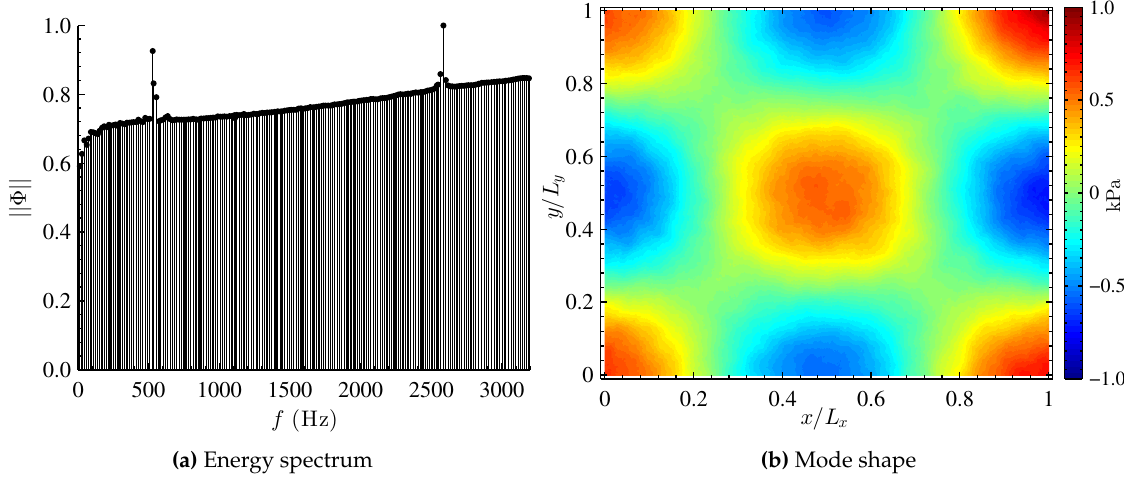
Figure 6. DMD results for mode ( 2,2,0 ) , with a theoretical frequency of 2594 Hz and a measured frequency of 2584